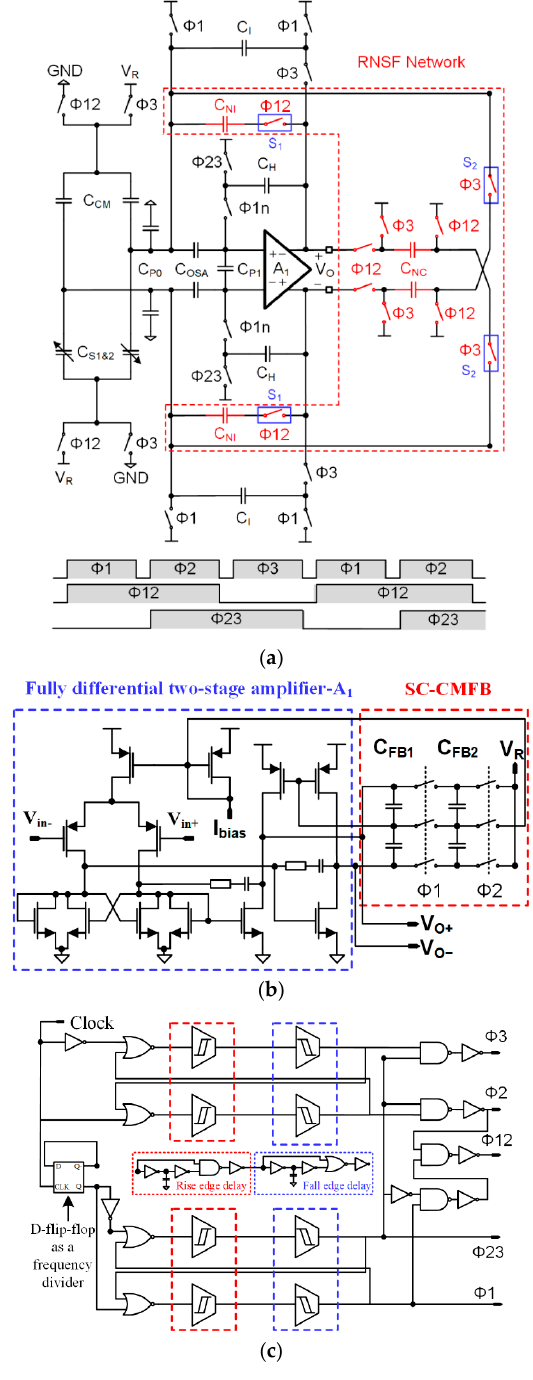
Figure 5. Circuit implementation of proposed capacitance-to-voltage converter based on the RNSF technique for a differential MEMS capacitive accelerometer. ( a ) Schematic and timing diagram. ( b ) Fully differential two-stage amplifier with SC-CMFB. ( c ) Three-phase non-overlapping clock generator.